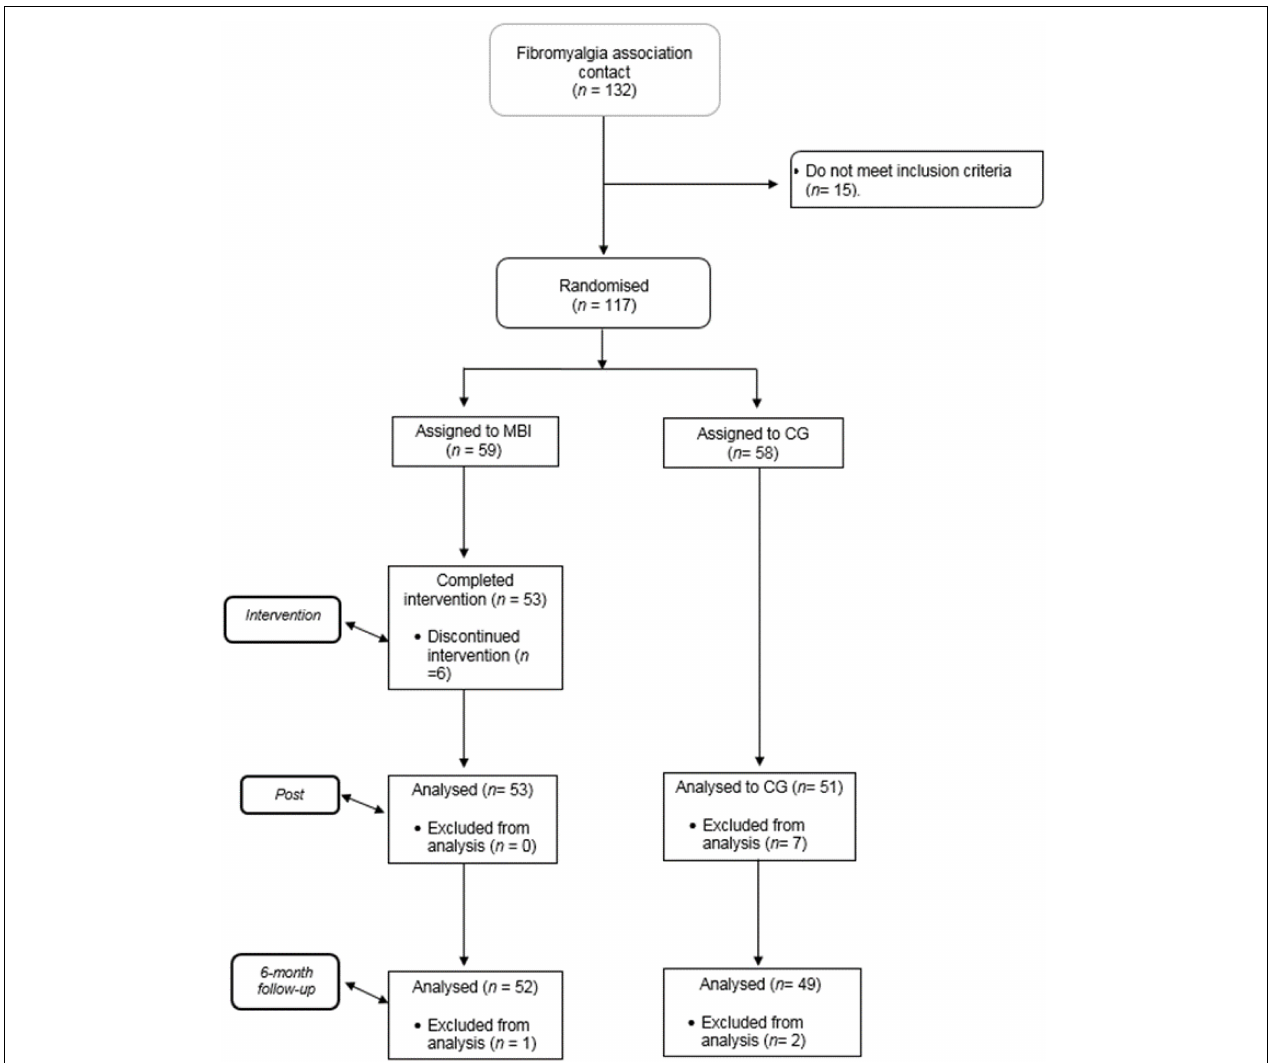
FIGURE 1 | Participant flow diagram. MBI mindfulness-based cognitive therapy (EG), treatment as usual control group condition